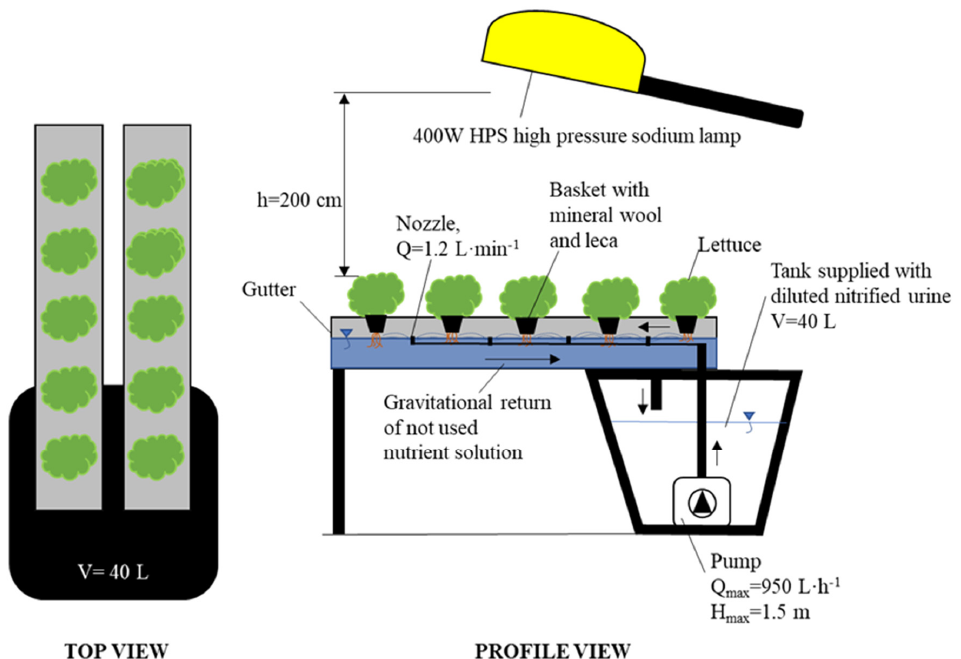
Figure 2. Schematic of a single hydroponic module.